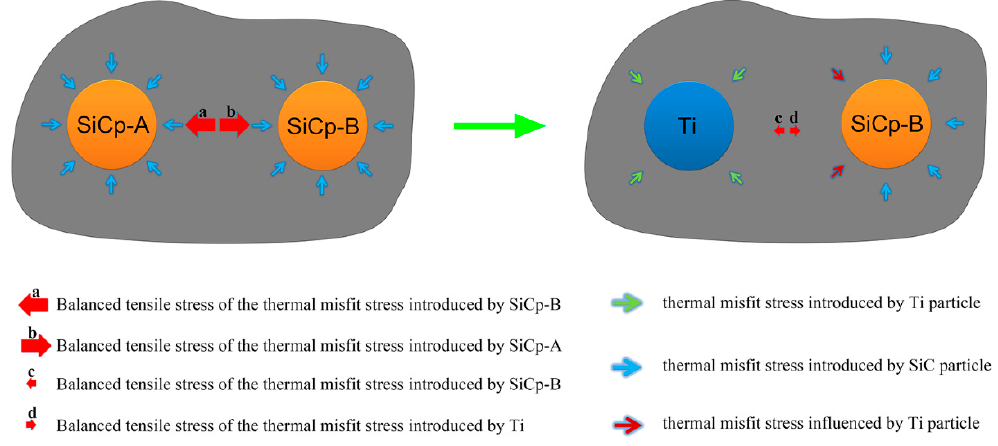
Figure 12. Schematic diagram of the influence of Ti particle on the thermal misfit stress in matrix.